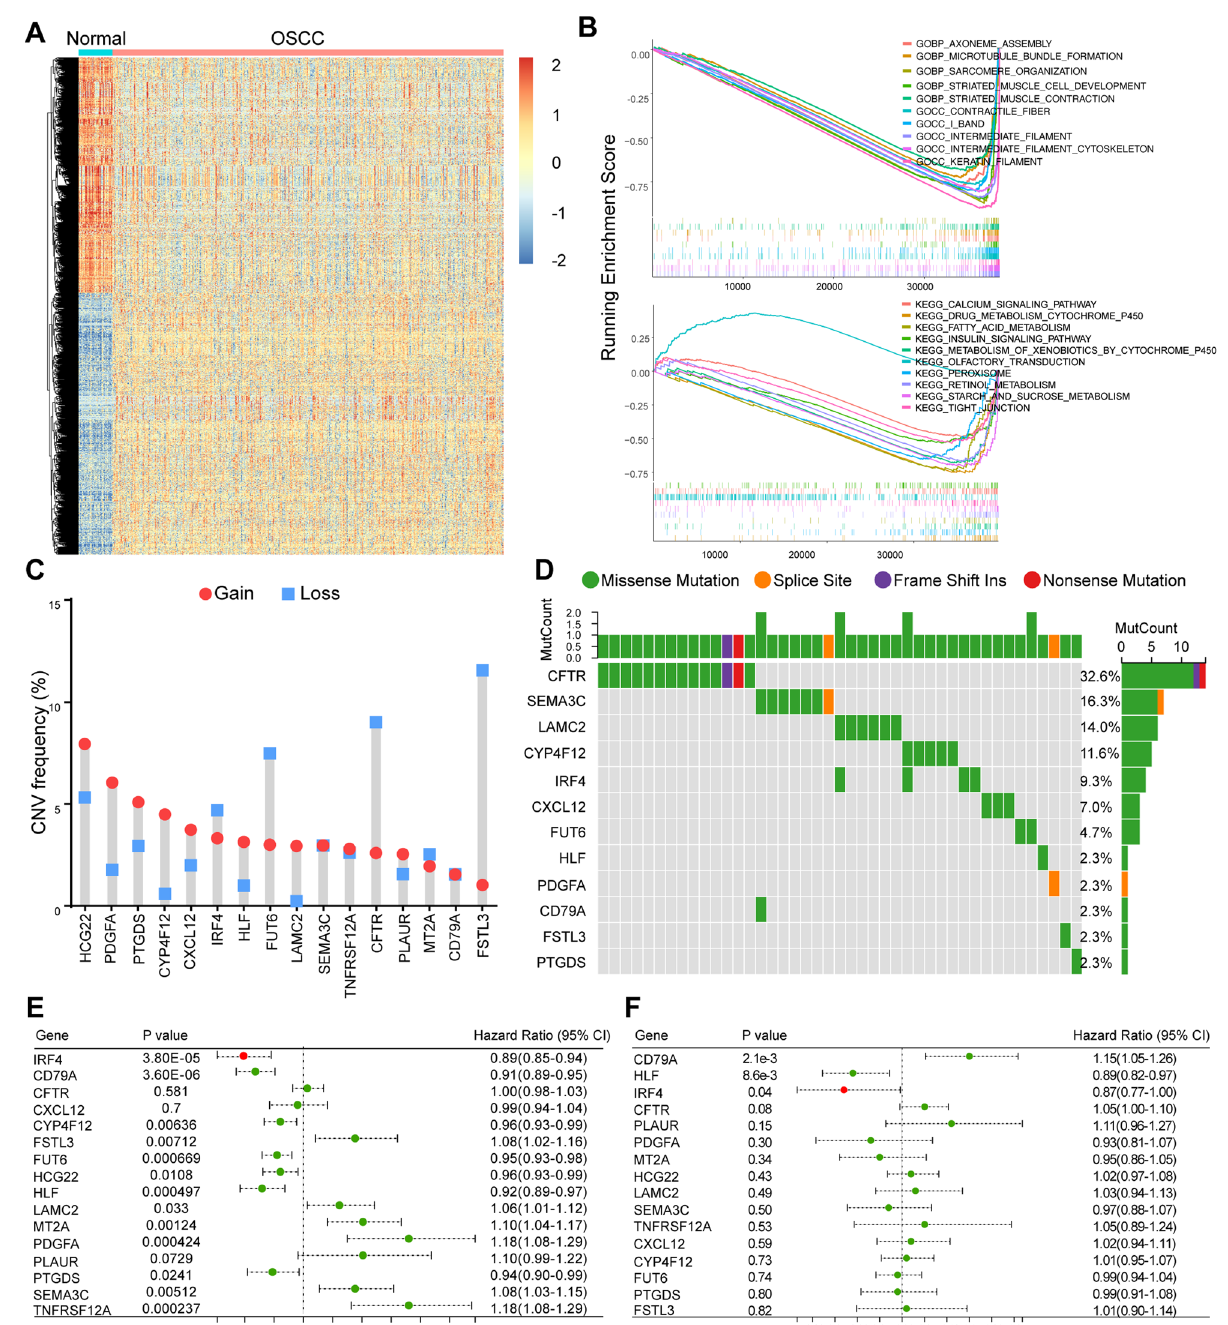
Figure 3. Screening of hub genes assisted with TCGA database. ( A ) Hierarchical clustering analysis of the differentially expressed genes between normal and OSCC from TCGA database. ( B ) GSEA analysis of OSCC in TCGA database. ( C ) Copy number variation (CNV) frequency of the 16 genes in TCGA cohort. CNV gain, red; CNV loss, blue color. The height of the column represents the alteration frequency. ( D ) Mutation frequency and classification of the 16 genes in OSCC. ( E ) Univariate Cox analysis of 16 DEGs with prognostic significance in TCGA OSCC datasets. ( F ) Multivariate Cox analysis 16 DEGs with prognostic significance in TCGA OSCC